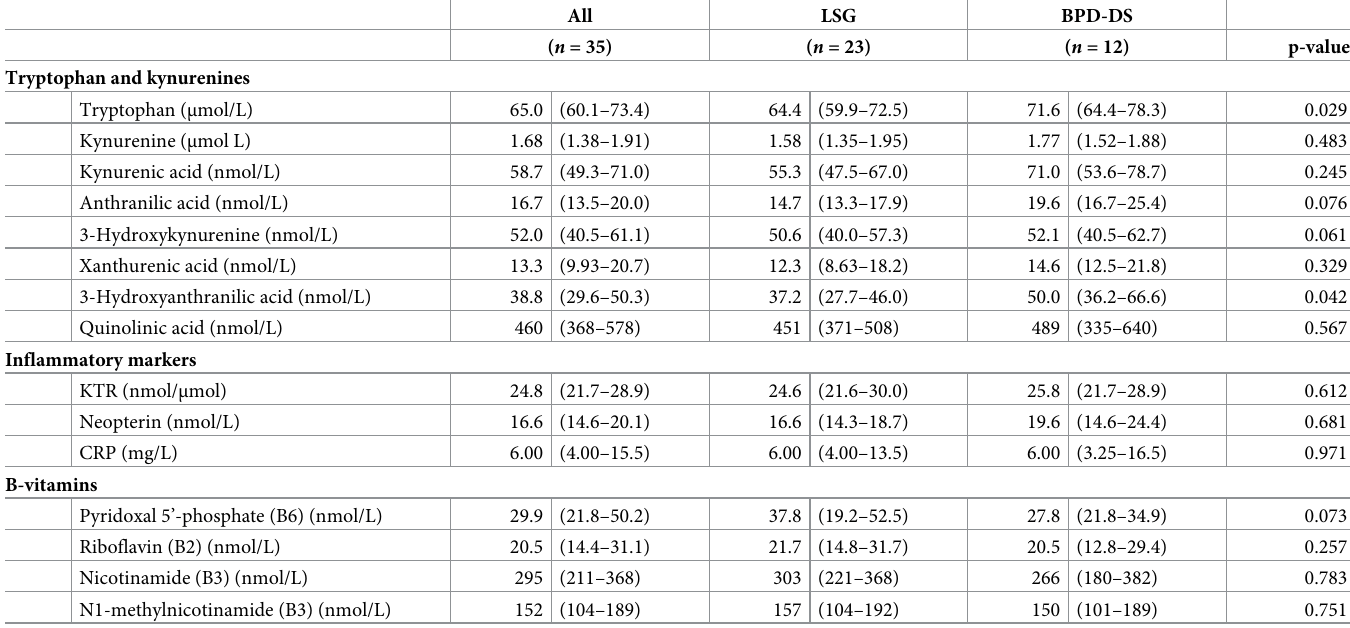
Table 2. Circulating levels of kynurenines, neopterin and B vitamins at inclusion of patients undergoing bariatric surgery. All